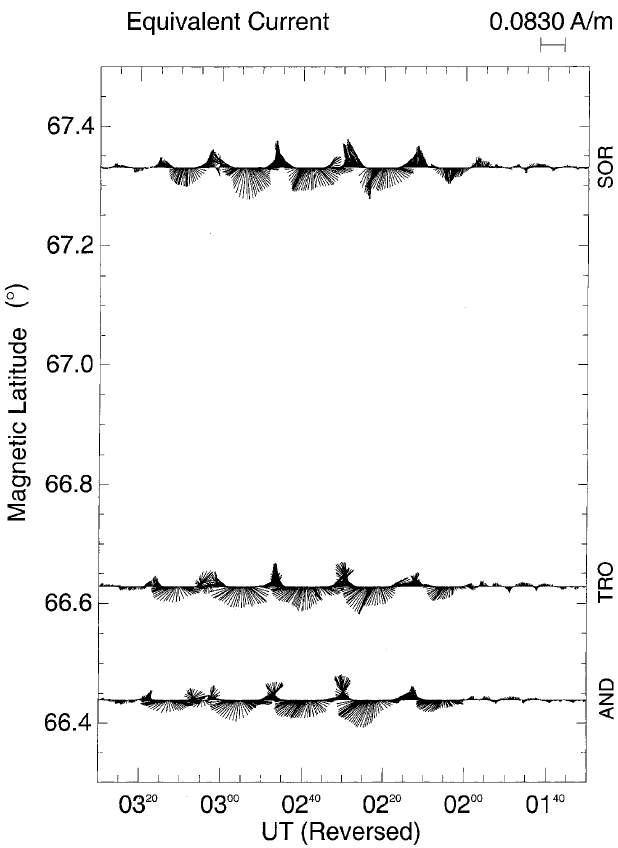
Fig. 5. Equivalent current patterns deduced from IMAGE magne- tometer data. The current vectors have been plotted against a reversed time axis. This is appropriate for visualising eastward moving features. The TRO and AND time series have been shifted by 180 and 350 s respectively to account for the propagation delay between those magnetometers and